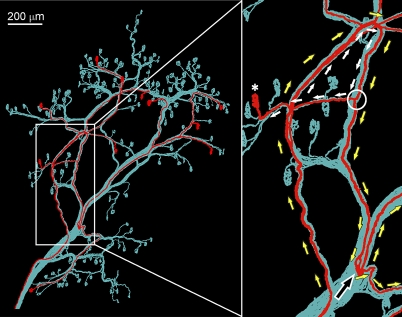
Suboptimality of Wiring Length of Individual AxonsWiring of a motor axon (red, M4L6, see Figure 3B) was superimposed on the nerve fascicles (blue) of the entire muscle. (Right) The axon took a long detour (yellow arrows) even though a much shorter path existed (black arrow). In addition it did not directly branch to innervate the NMJ to the left (*) but only reached it after looping back (white arrows) and bifurcating at the white circle. This kind of suboptimality in wiring length was observed in almost all connectomes.